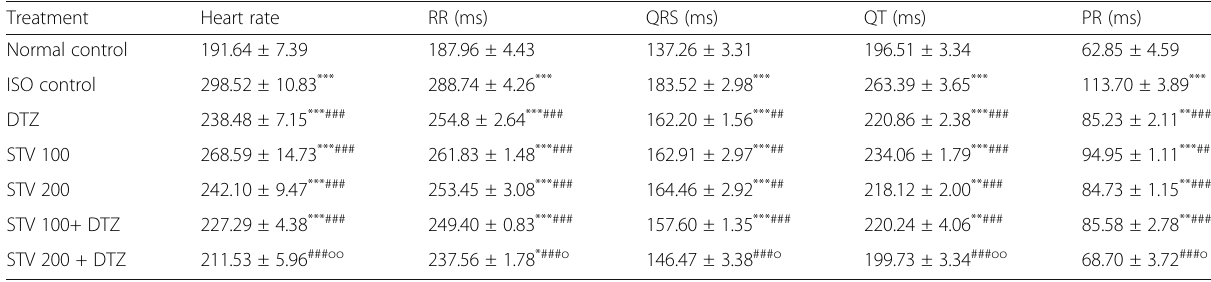
Table 3 Effect of STV, DTZ, and their combinations on electrocardiographic parameters in isoproterenol-induced myocardial infarction